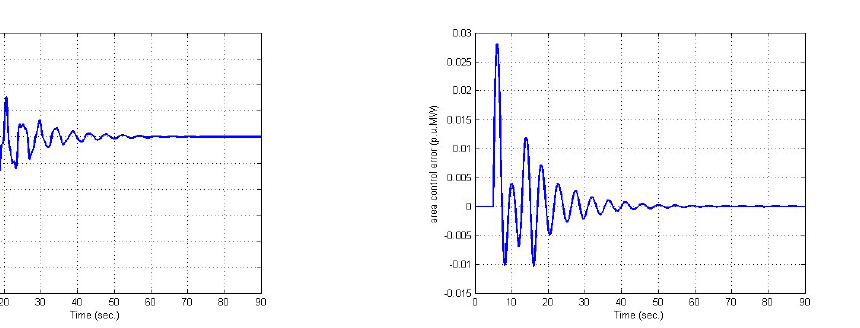
Fig. 12: Frequency deviation of area-1 (Case 3)